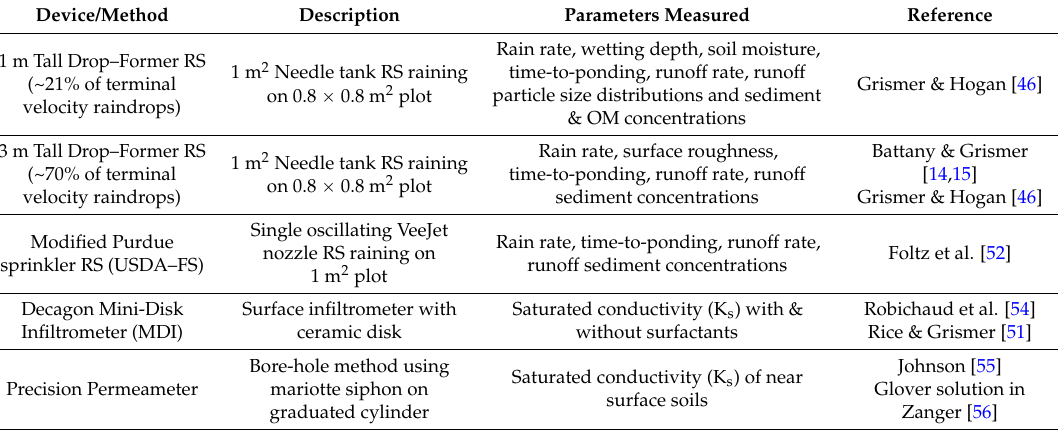
Table 3. Summary of field measurement methodologies used to develop the datasets considered in the infiltration, soil detachment and RS comparisons